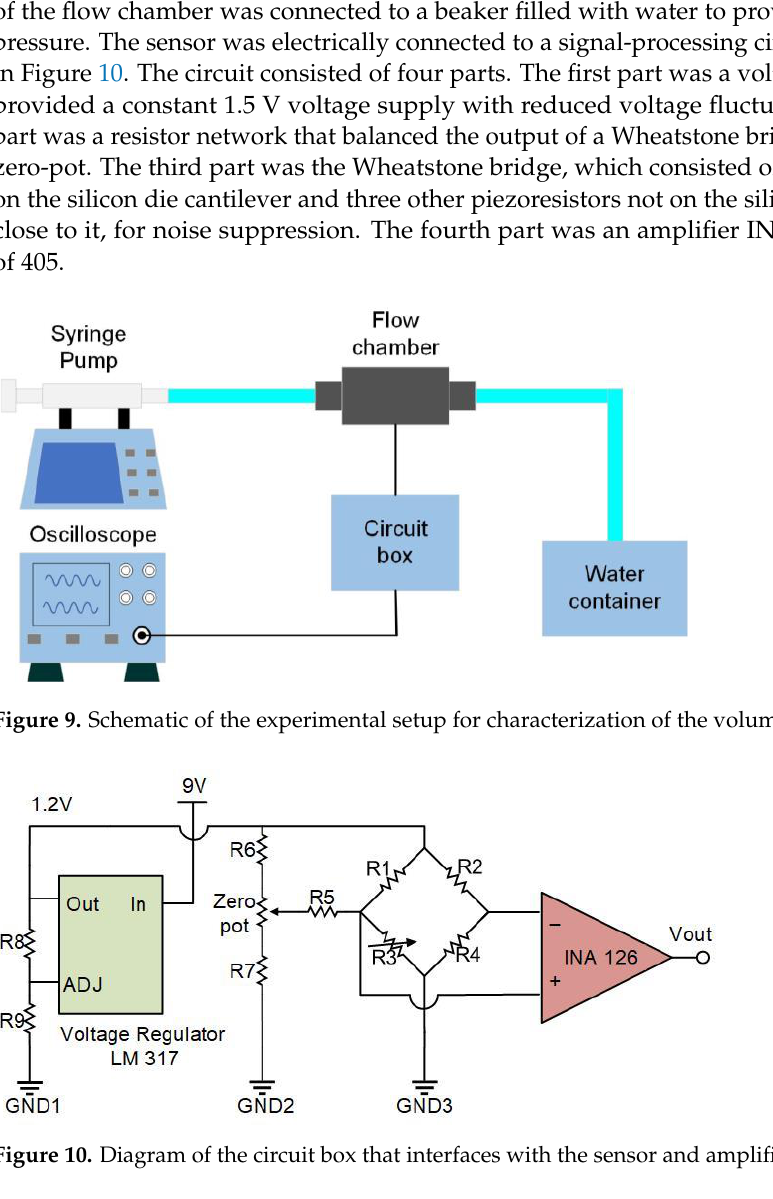
Figure 8. ( a ) Assembled volumetric flow sensor with sensing hairs in the middle of the fluid passage. ( b ) Colored water runs through the fluid passage of the sensor.